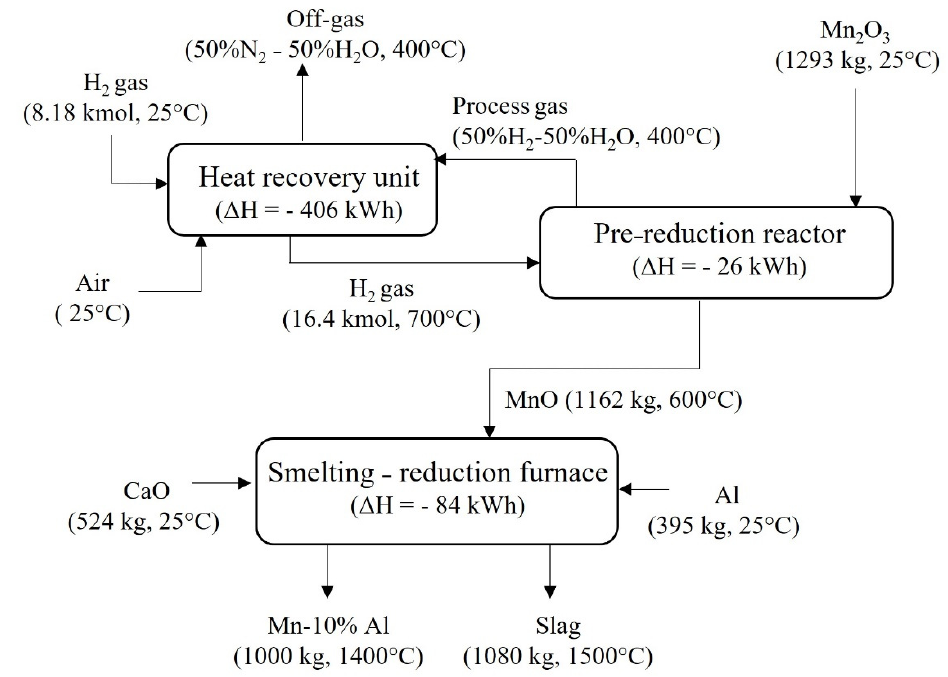
Figure 8. Mass and energy balances for the different units of HAlMan process for Mn − 10%Al production.